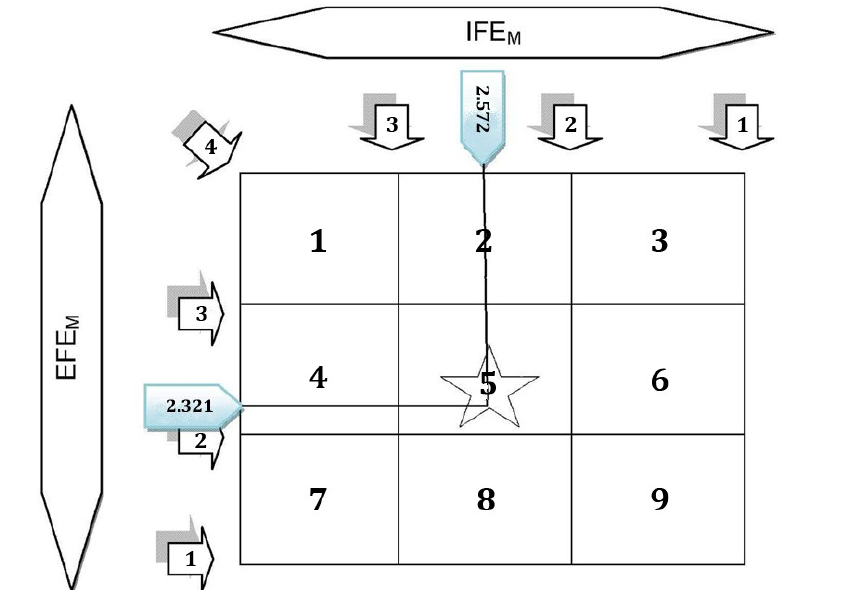
Figure 1. Matrix of strategies and executive priorities of municipal waste management